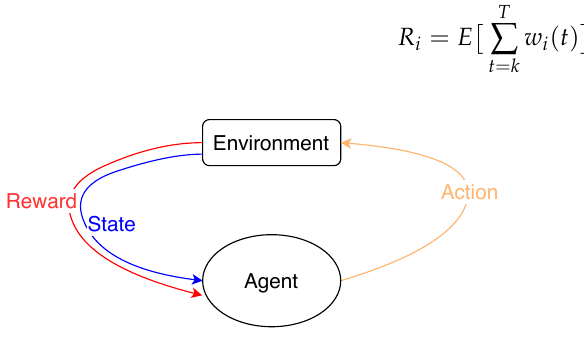
Figure 3. Markov decision